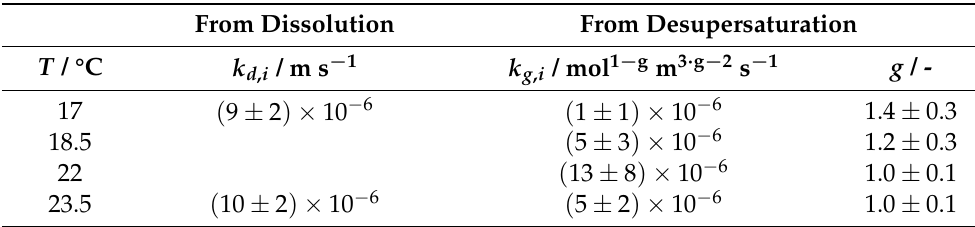
Table 2. List of binary kinetic coefficients k g , i and crystallization orders g of sodium carbonate decahydrate at different equilibrium temperatures. From Dissolution From